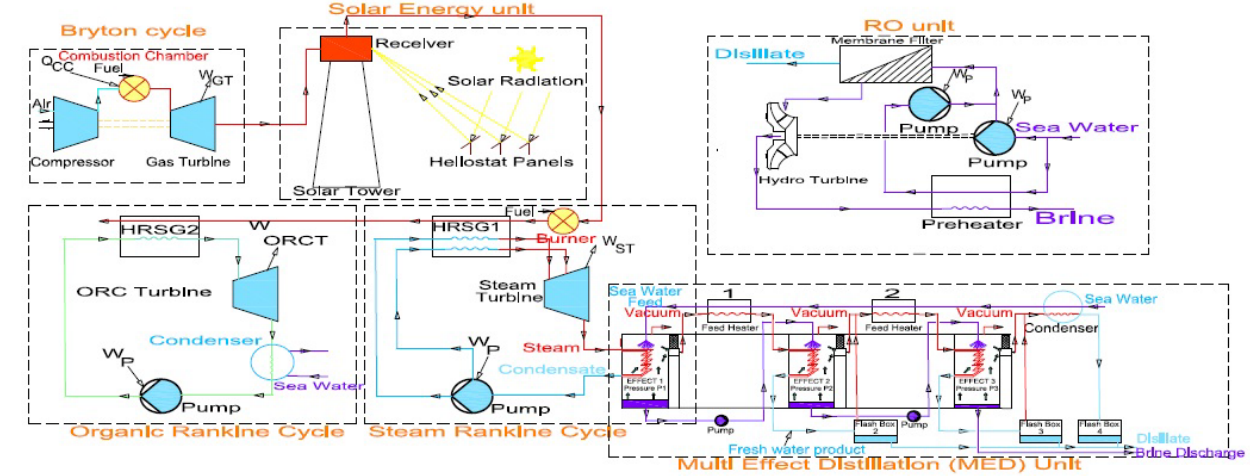
Figure 1. Schematic of the GT, HRSG, ST, ORC, RO, and MED systems for the generation of electricity and fresh water using fossil fuels and solar energy.